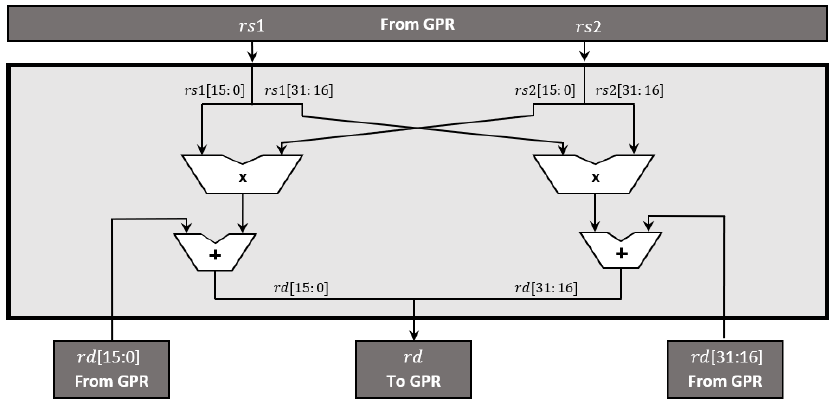
Figure 4: Vectorized Modular Multiply Accumulate ( pq.mac